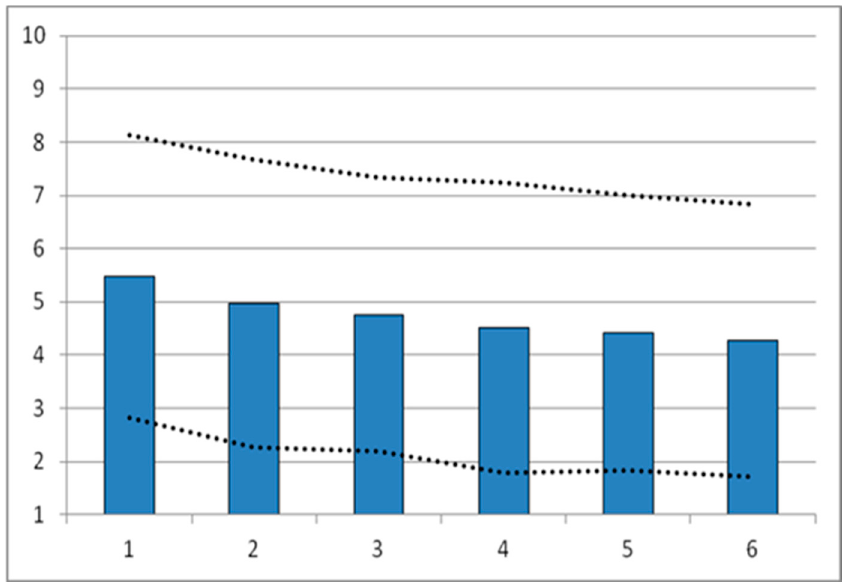
Figure 1. Barriers limiting the accessibility of sports and recreation facilities based on the opinions of service recipients— X ± S. Figure Legend: 1. High prices in a sports and recreation facility; 2. Long distance between a sports and recreational facility and the place of residence; 3. General accessibility of a sports and recreation facility; 4. Lack of preferred activities in a sports and recreation facility; 5. Transport difficulties; 6. The object is intended for competitive